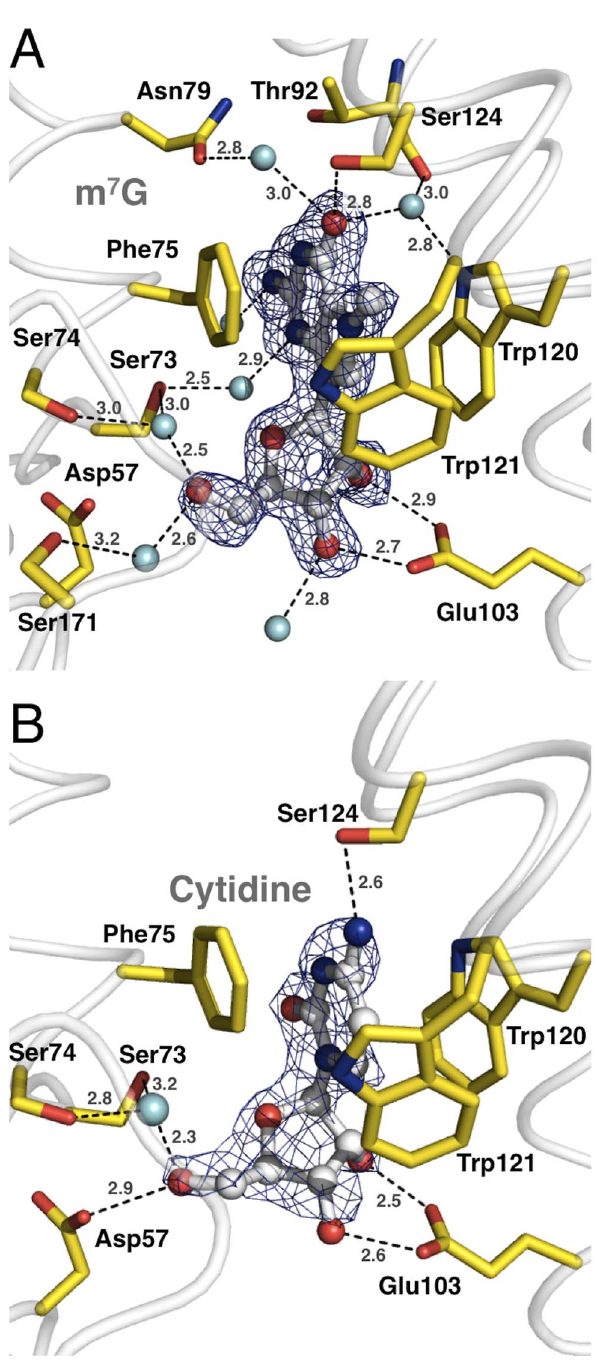
Figure 4. Detail view on the substrate-binding pocket of Dm cN- IIIB. (A) The co-crystallized reaction product 7-methylguanosine is shown in ball-and-stick mode (carbon in grey, nitrogen in blue, oxygen in red) and is defined by an mF o – DF c omit-electron density map (blue mesh) contoured at a sigma level of 3.0. m 7 G is stacked in a coplanar but off-centered fashion by Phe75 and Trp120 (colors as in Figure 3 ). Trp121 packs by T-shaped edge-to-face stacking against the bound product and binding is additionally supported by numerous direct or water-mediated hydrogen bonds (dashed lines with distances) to various protein residues of Dm cN-IIIB. (B) Binding of the reaction product cytidine by Dm cN-IIIB. In contrast to m 7 G, the nucleobase moiety of cytidine makes only a hydrogen bond to